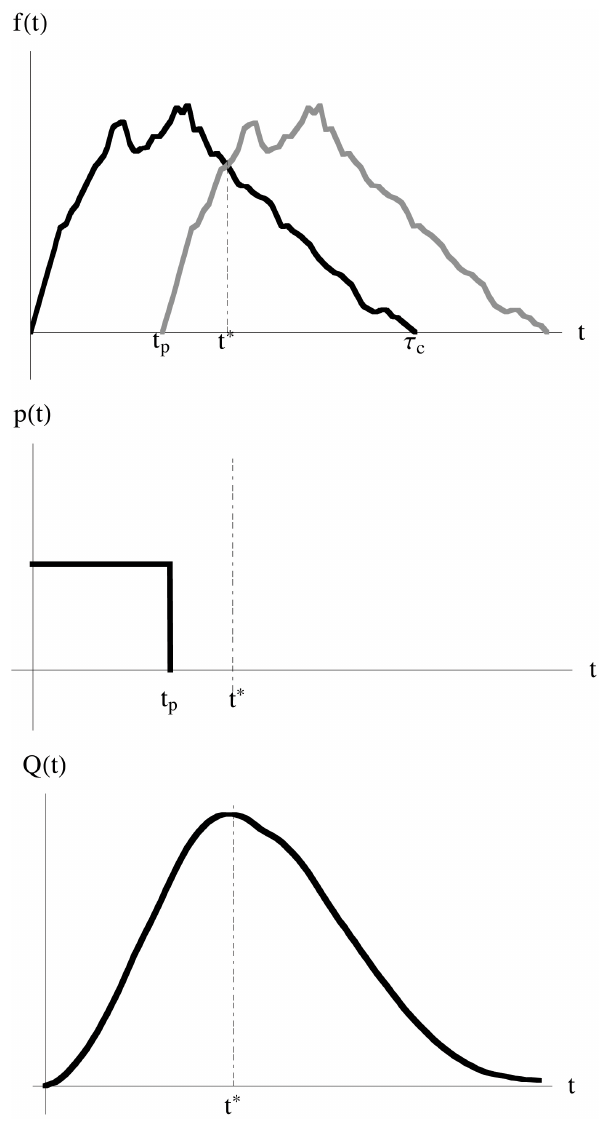
Fig. 1. The solutions of Eq. (4) are given by the crossing of the unit hydrograph f (t) with another unit hydrograph, f (t − t p ) , shifted by a distance, t p . The figure shows: (a) the graphical solution of the equation (in black f (t) and in grey f (t − t p )) ; t ∗ is the time to peak. (b) t ∗ is usually larger than t p . This is true for constant intensity uniform hyetograph; (c) the discharge obtained by the convolution of the IUH in (a) with the rainfall in (b)